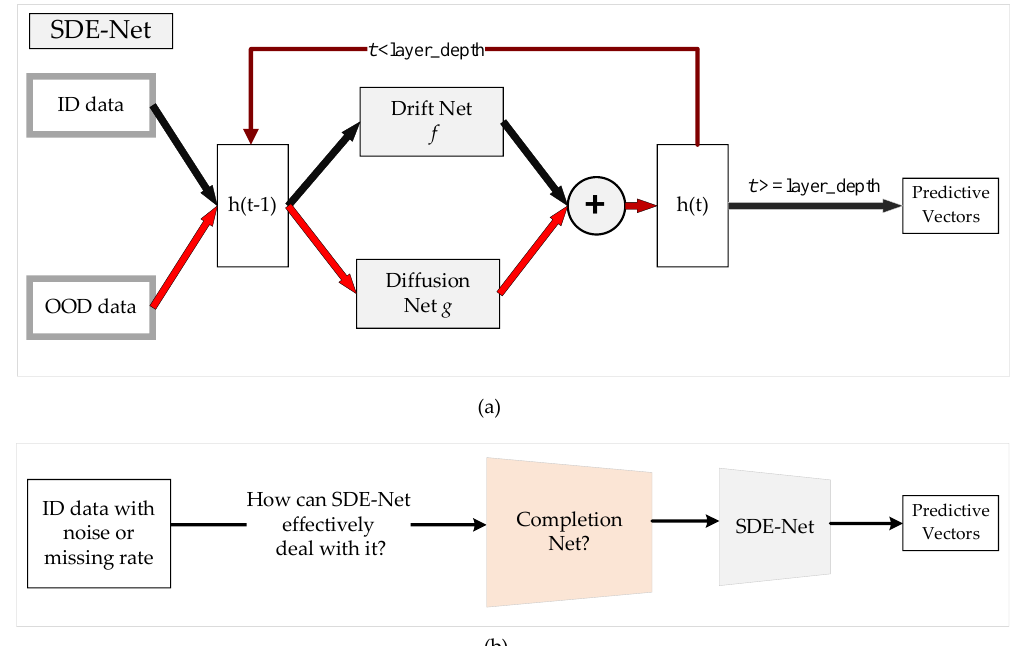
Figure 1. Illustration of SDE-Net and the problems it faces. ( a ) Components of SDE-Net. For ID data, SDE-Net is dominated by the drift net in order to achieve good predictive accuracy. For OOD data, SDE-Net is dominated by the diffusion net in order to generate high diffusion for characterizing model uncertainty. ( b ) Flowchart explaining how to resolve the problems faced by SDE-Net.